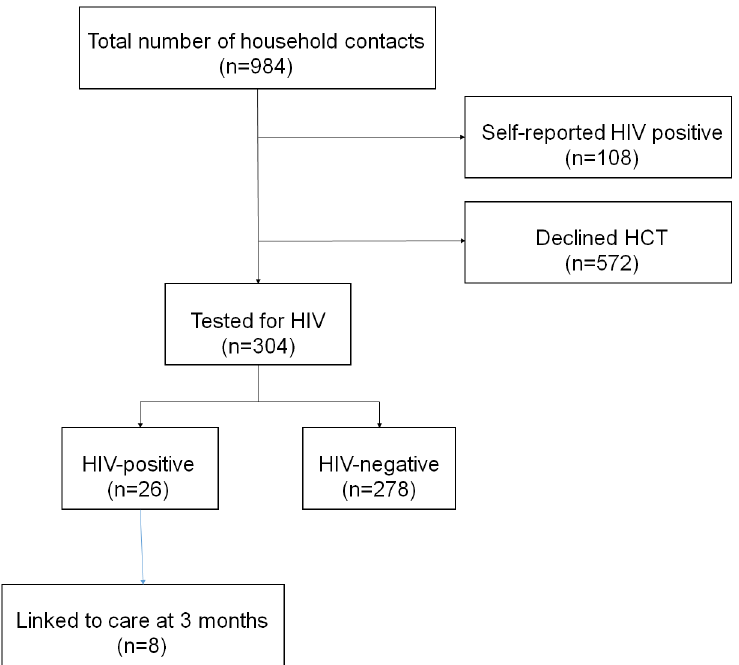
Fig 1. Flow diagram of household contacts present at home and screened for